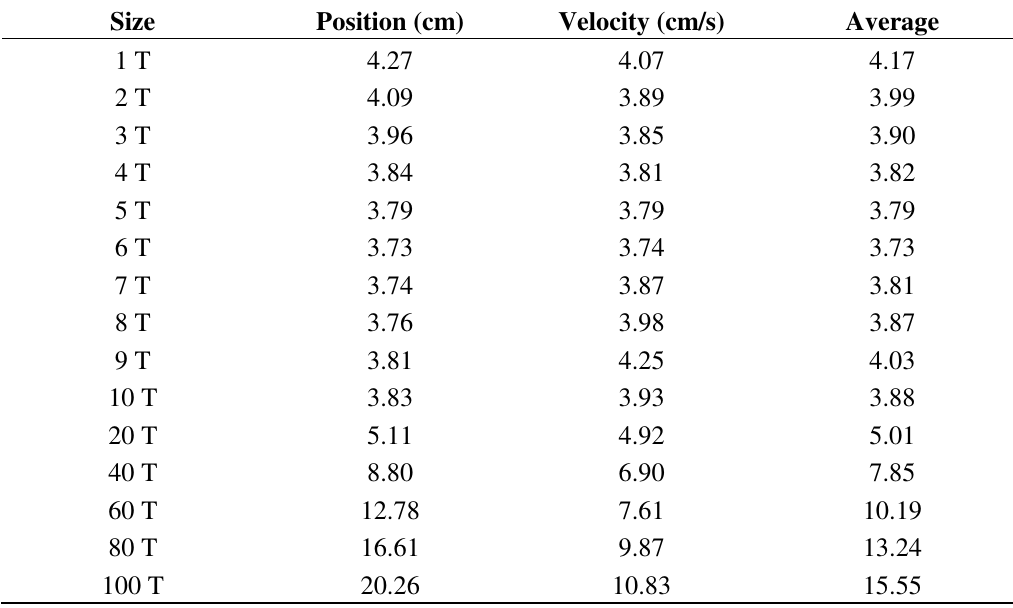
Table 7. The average of average RMSEs for position and